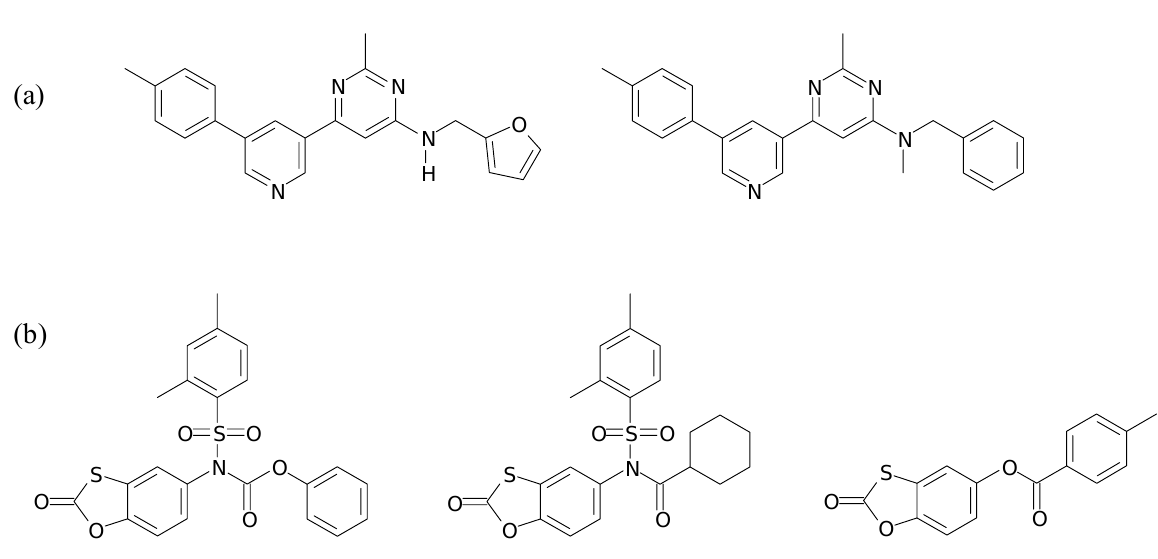
Figure 3. Classes of novel haem-targeting chemotypes identified through a modified HTS assay [51]: (a) pyrimidines and (b)